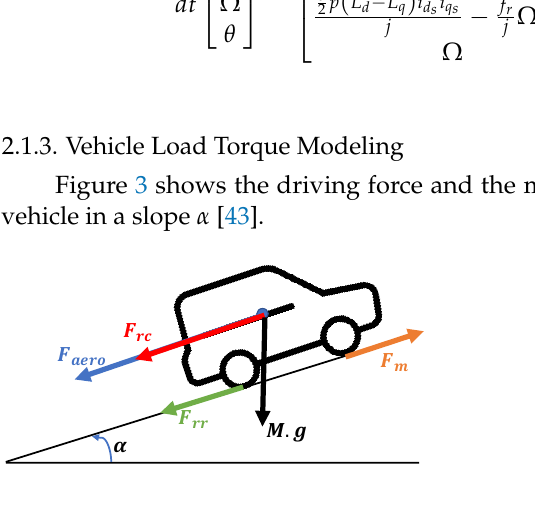
Figure 3. The typical driving force and resisting forces components of a vehicle